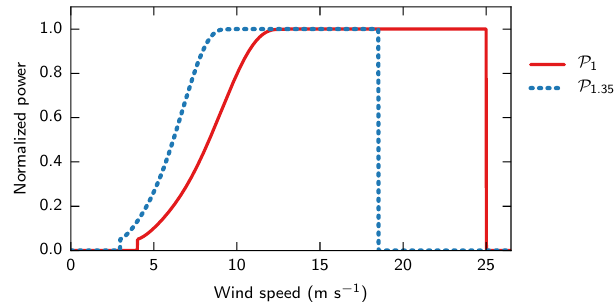
Figure 1. Example of the power curves used to compute the power production P . In red ( P 1 ) the power curve of a Vestas V90/2000 wind turbine normalized by its rated power (2MW) is shown. In dashed blue ( P 1 . 35 ) the power curve adapted from the previous one by a linear transformation of factor a = 1 . 35 is